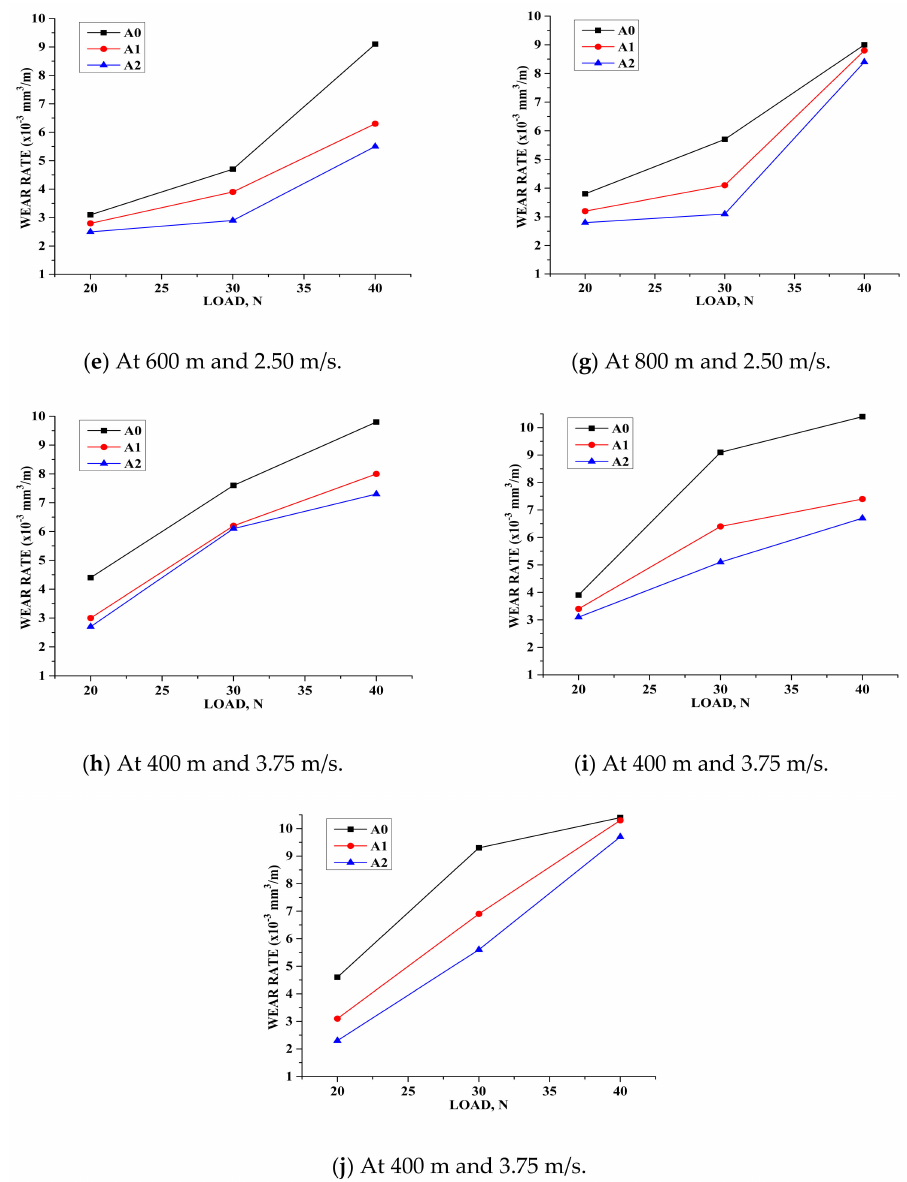
Figure 8. Wear rate vs.